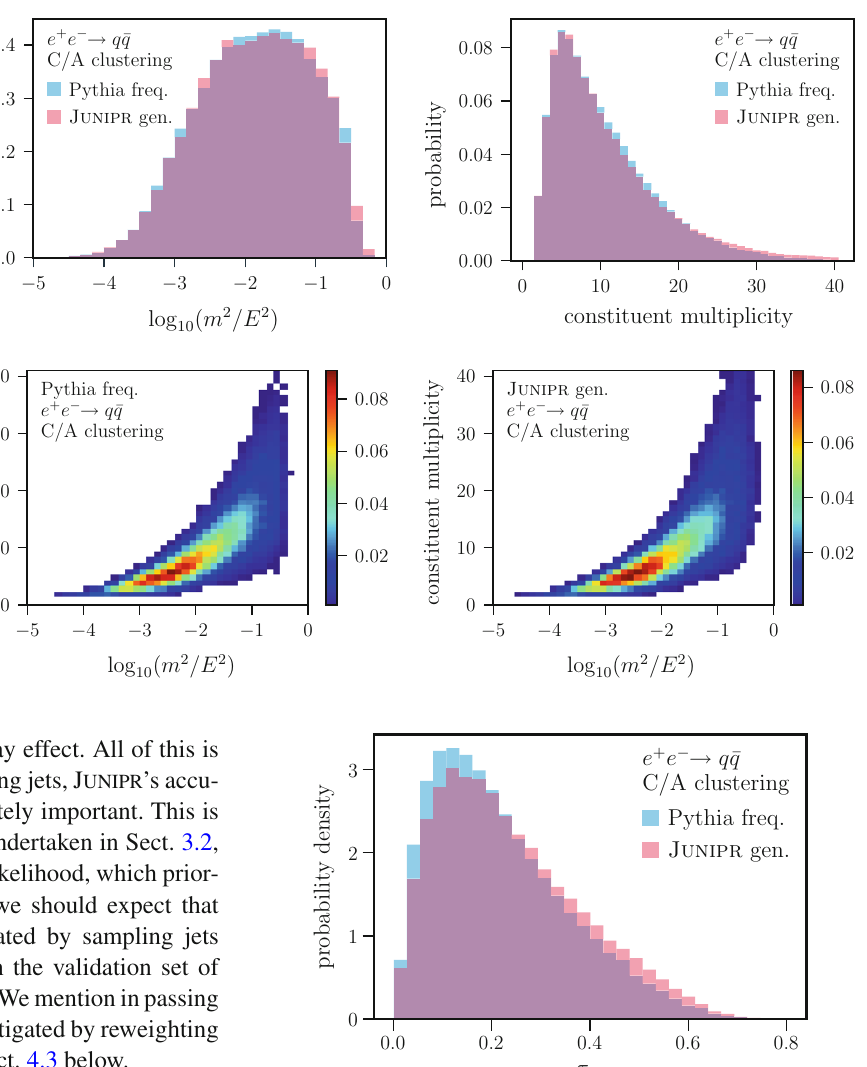
Fig. 17 2-Subjettinessratioobservablecomputedonjetssampledfrom Junipr . Disagreement with the distribution on Pythia jets, due to the feedback involved in sampling from Junipr , is visible. This disagree- ment is amended in Fig.